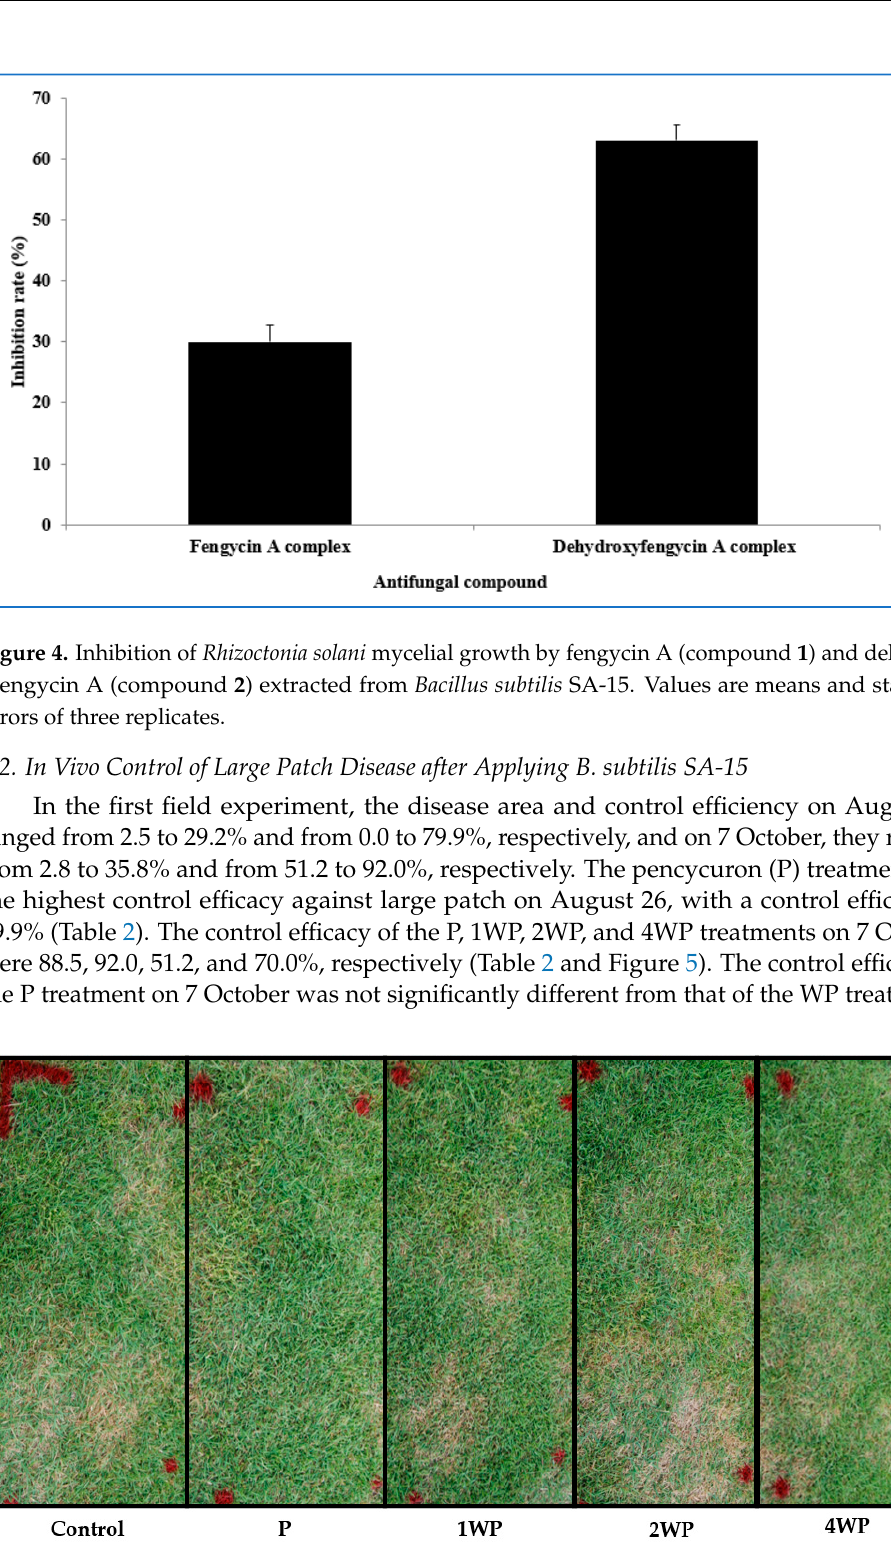
Figure 5. Control of large patch by application of Bacillus subtilis SA-15 (WP). Treatments were as follows: control, no treatment; P, 1.0 mL · m − 2 pencycuron; 1WP, 1.0 g · m − 2 WP; 2WP, 2.0 g · m − 2 WP; and 4WP, 4.0 g · m − 2